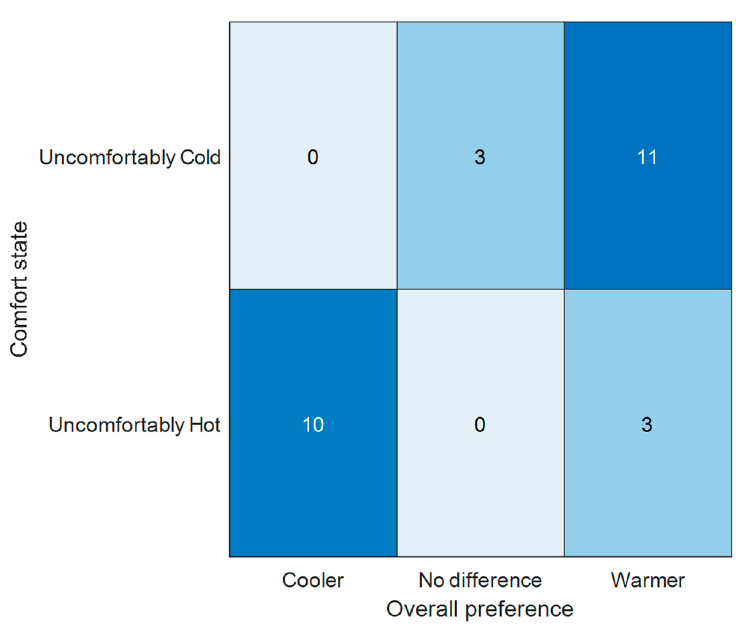
Figure 8. Comfort survey votes in recovery phases (Phases 3 and 5) vs. overall thermal preference for subjects.